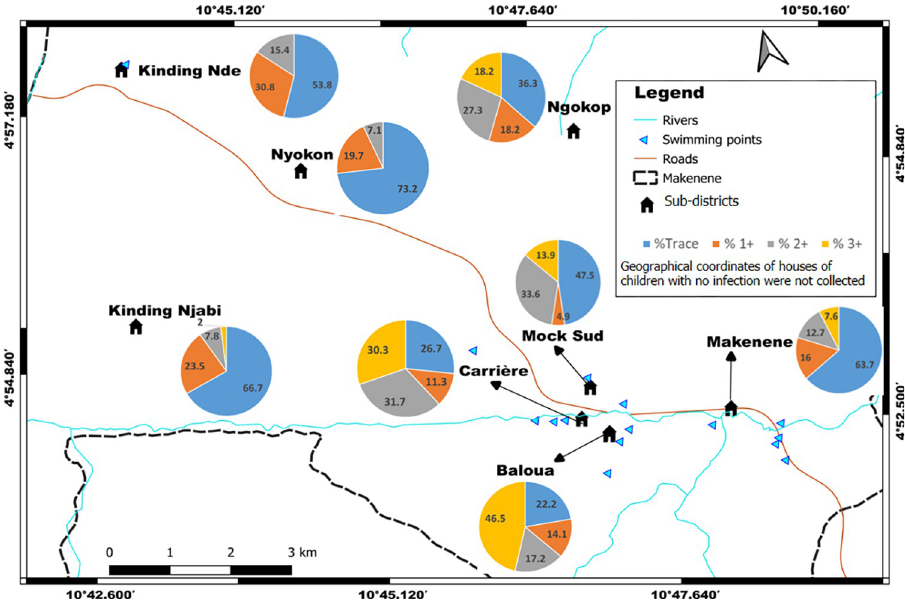
Fig 4. Sub-districts distribution of the percentage of children carrying different infection intensities inferred from POC-CCA (base layer of the maps were obtained using a free online spatial data software (https://www.diva-gis.org/